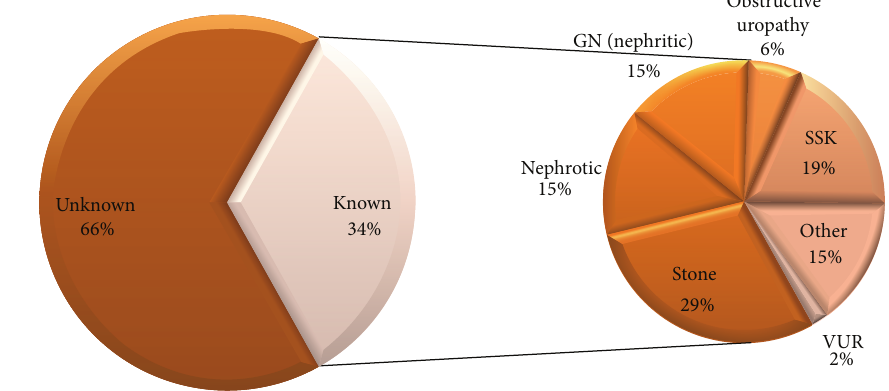
Figure 1: Percentage distribution of Aetiology of ESRD among children. Table 3: Stratified analysis of clinical status among children with